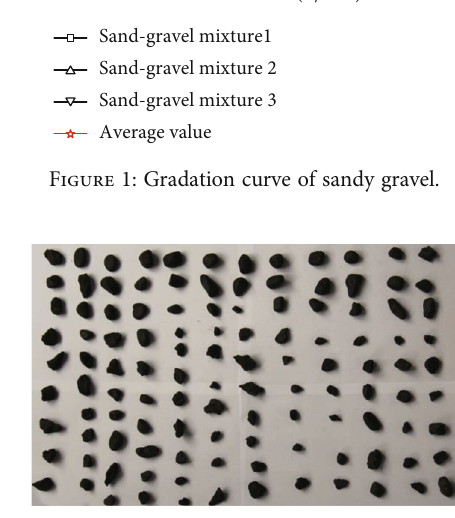
Figure 2: Image of blackened gravel particles with the diameter of 5 ~